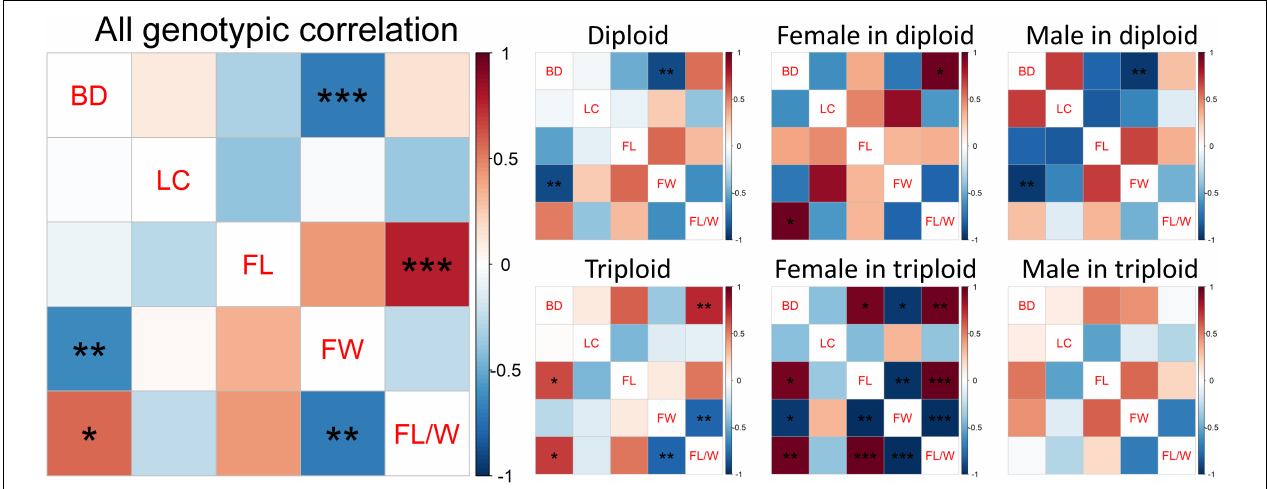
FIGURE 3 | Pearson’s correlation between wood and fiber traits. The upper and lower diagonals represent phenotypic and BLUP correlations, respectively. BD, Basic density; LC, Lignin content; FL, Fiber length; FW, Fiber width; FL/W, Fiber length/width. *, **, and *** represent significance at 0.05, 0.01, and 0.001 levels, respectively.